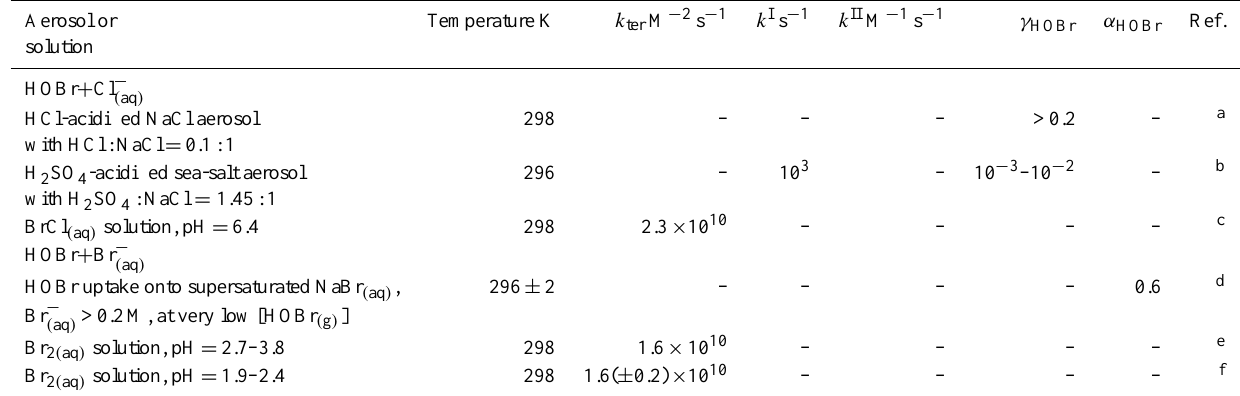
Table 1. Summary of experimental data reported on HOBr uptake coefficient and HOBr ( aq ) reaction kinetics under tropospheric conditions. Aerosol or Temperature